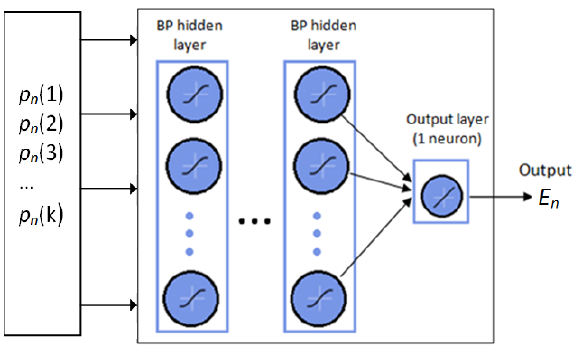
Figure 8. Structure of LSTM proposed network.